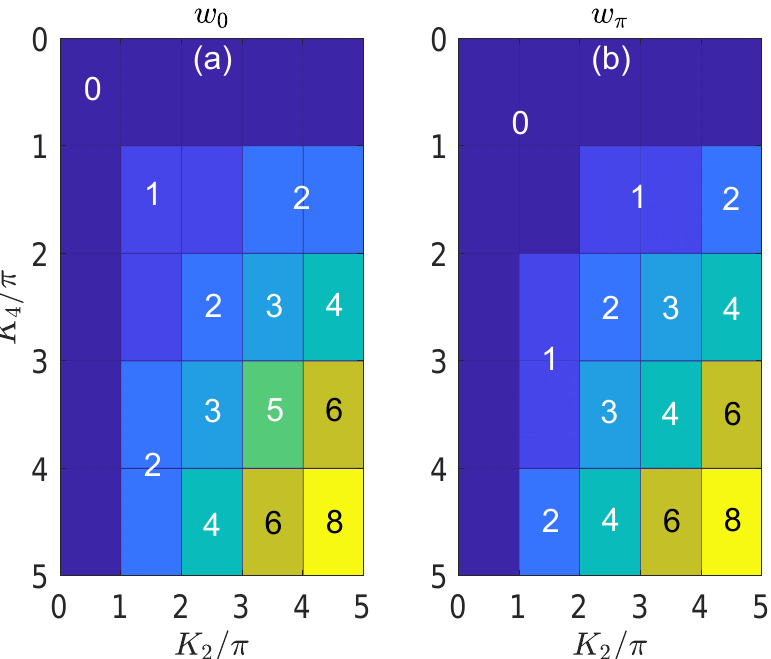
Figure 1. Topological phase diagram of the 2D on-resonance double-kicked lattice versus the kicking strengths K 2 and K 4 . The other system parameters are set as K 1 = K 3 = 0.5 π . Different Floquet HOTPs are distinguished by different colors in each panel. The values of w 0 ( w π ) for different topological phases are obtained from Equation (33) [(34)] and denoted explicitly in ( a ) [( b )].